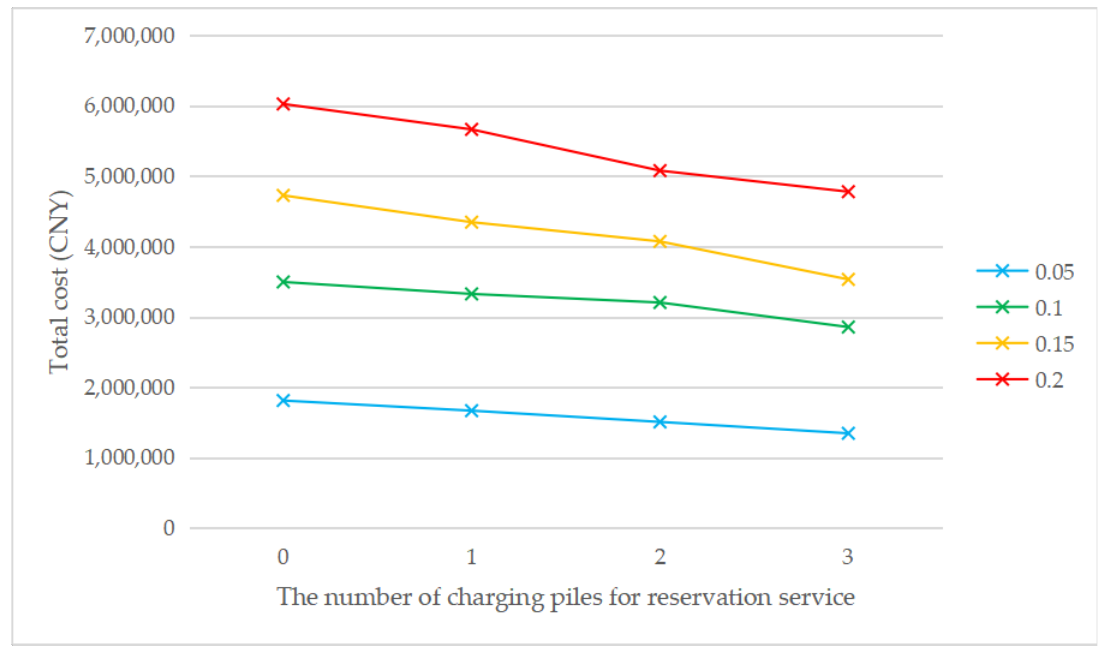
Figure 5. The total cost of changing the number of charging piles for the reservation service under different penetration rates.